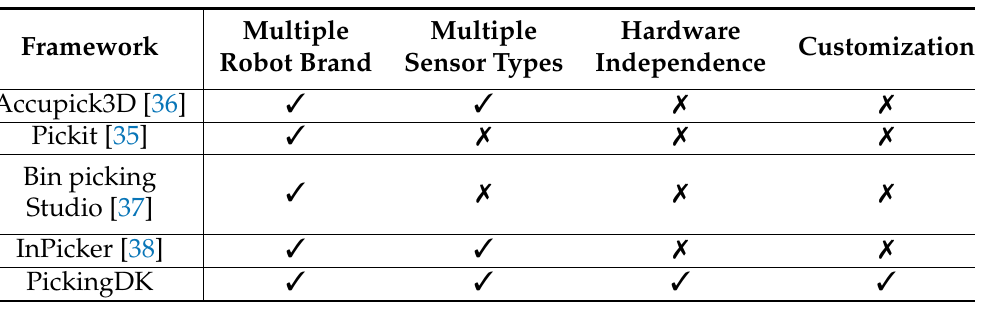
Table 2. Framework